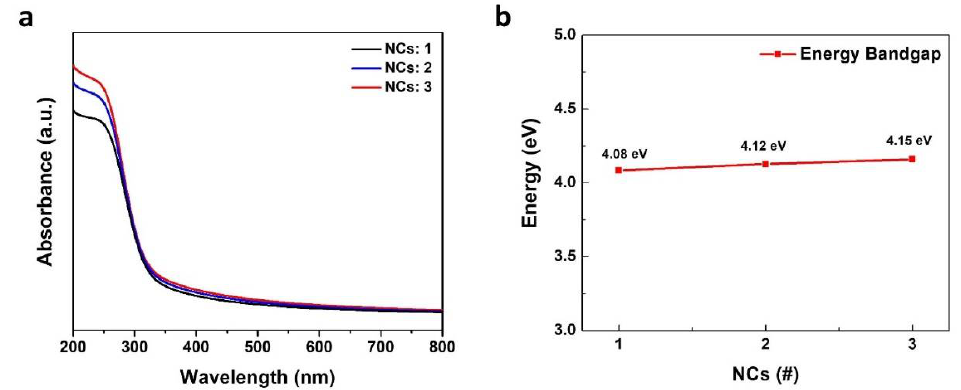
Figure 5. 2D ( a – c ) and 3D ( d – f ) AFM characterization of CTO thin films with different numbers of spin-coating cycles.